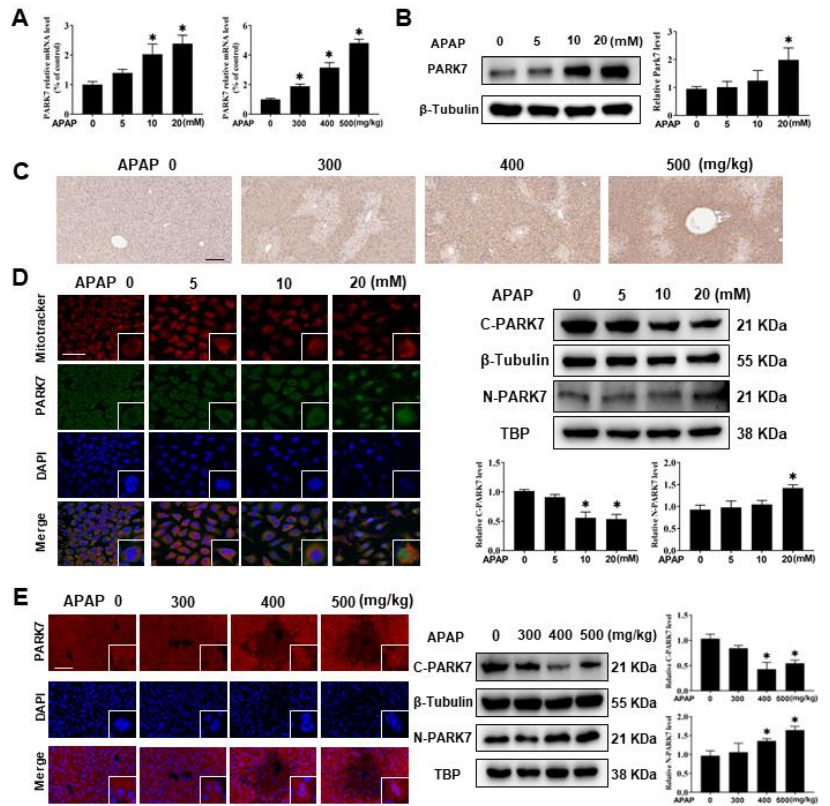
Figure 2. PARK7 expression increased in the APAP acute liver injury model. ( A ) PARK7 mRNA expression was detected in L02 cells and mouse liver tissues, N = 3. * p < 0.05 vs. the Ctr group. ( B ) Western blotting (WB) and statistical analysis of PARK7 protein in L02 cells, N = 3. * p < 0.05 vs. the Ctr group. ( C ) The expression of PARK7 in liver tissue of mice was detected by immunohistochemical staining, N = 3. ( D ) Immunofluorescence staining and nucleation analysis of L02 cells, N = 3. * p < 0.05 vs. the Ctr group. ( E ) Immunofluorescence staining and nucleation analysis of mouse liver tissues, N = 3. * p < 0.05 vs. the Ctr group. C represents the cytoplasm and N represents the nucleus.